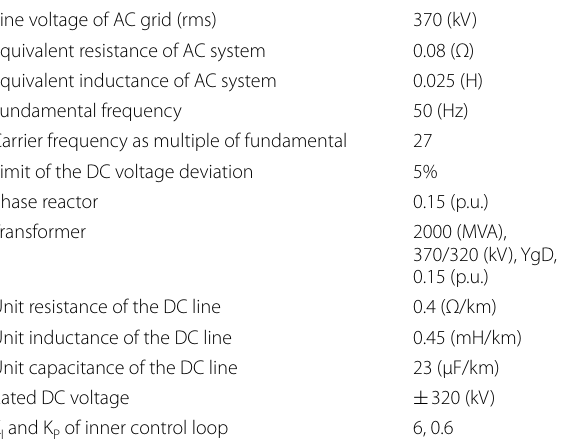
Table 1 Parameters of the VSC-MTDC test system